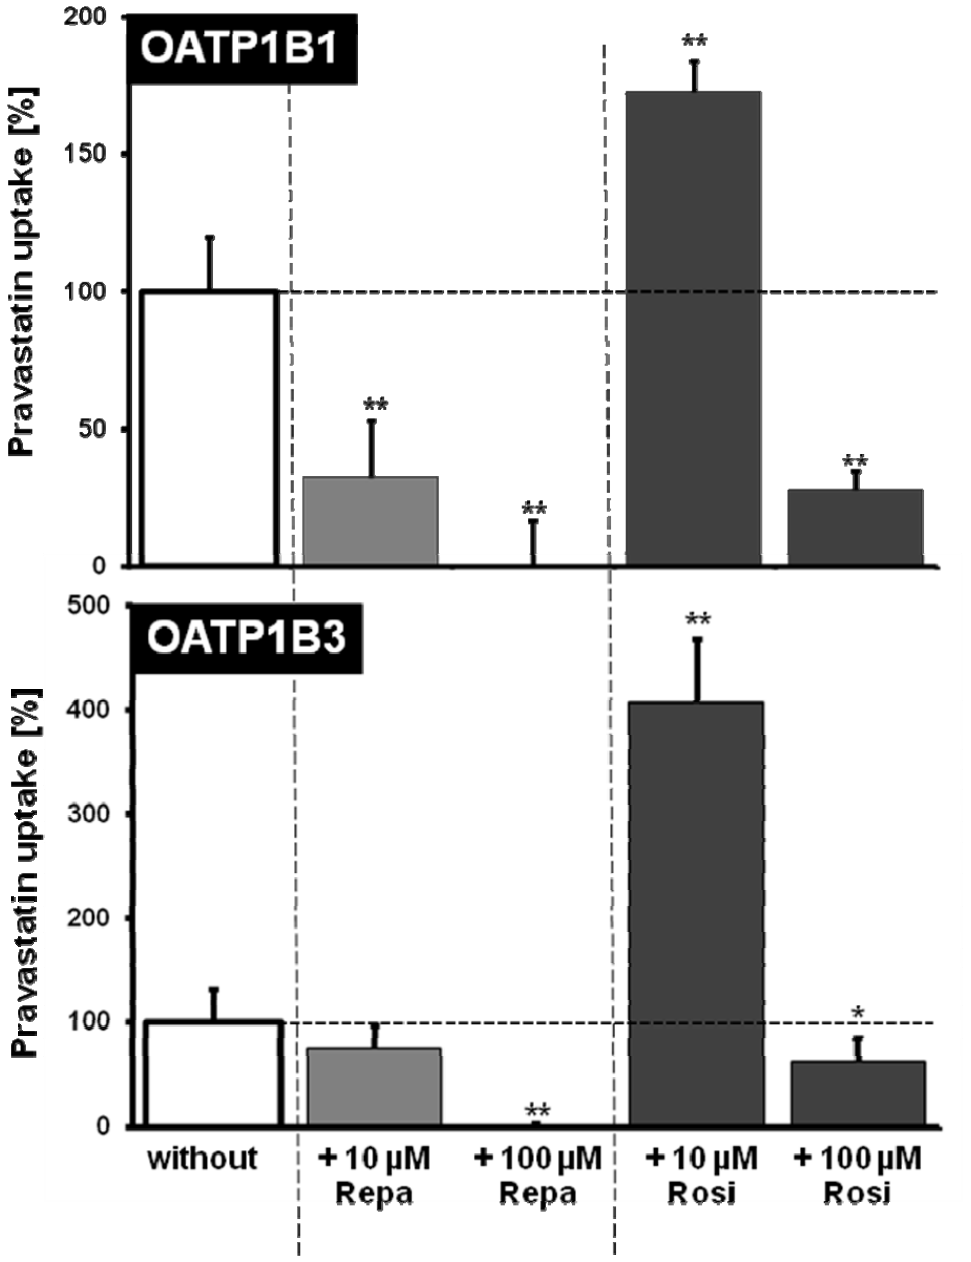
Figure 3. Inhibition of OATP1B1- (top) and OATP1B3-mediated (bottom) pravastatin uptake (50 µM) by the oral antidiabetic drugs repaglinide (Repa) and rosiglitazone (Rosi). Data are shown as the percentage of OATP1B1- or OATP1B3-mediated pravastatin uptake in the absence of the respective drug (without). * P < 0.05; ** P < 0.01 vs. control. (modified from